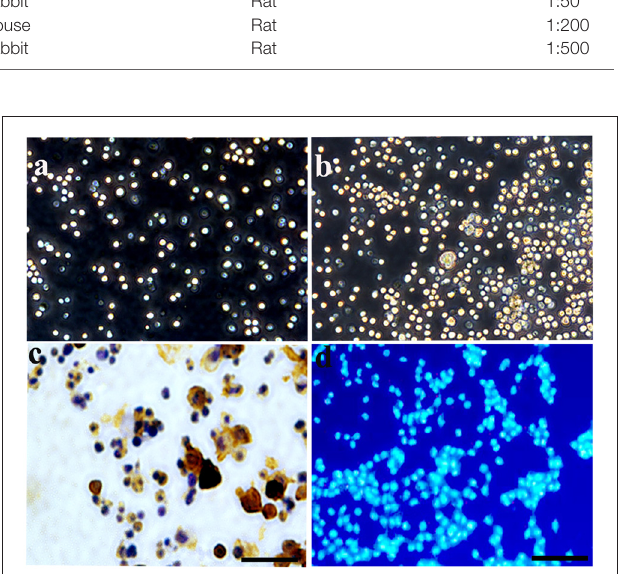
FIGURE 1 | Characterization and identification of hematopoietic stem cells (HSCs) cultured in vitro . (A) Under a phase contrast microscopy, HSCs exhibited a floating growth status at day 3, and the number increased greatly at day 7 (B) . (C) Enzyme histo-cytochemical staining at 3 days showed most of the cultured HSCs expressed CD34 demonstrating the purity of the cultured HSC. (D) HSCs were labeled by Hoechst 33342 with nucleus staining, showing a blue color. Bar = 50 µ